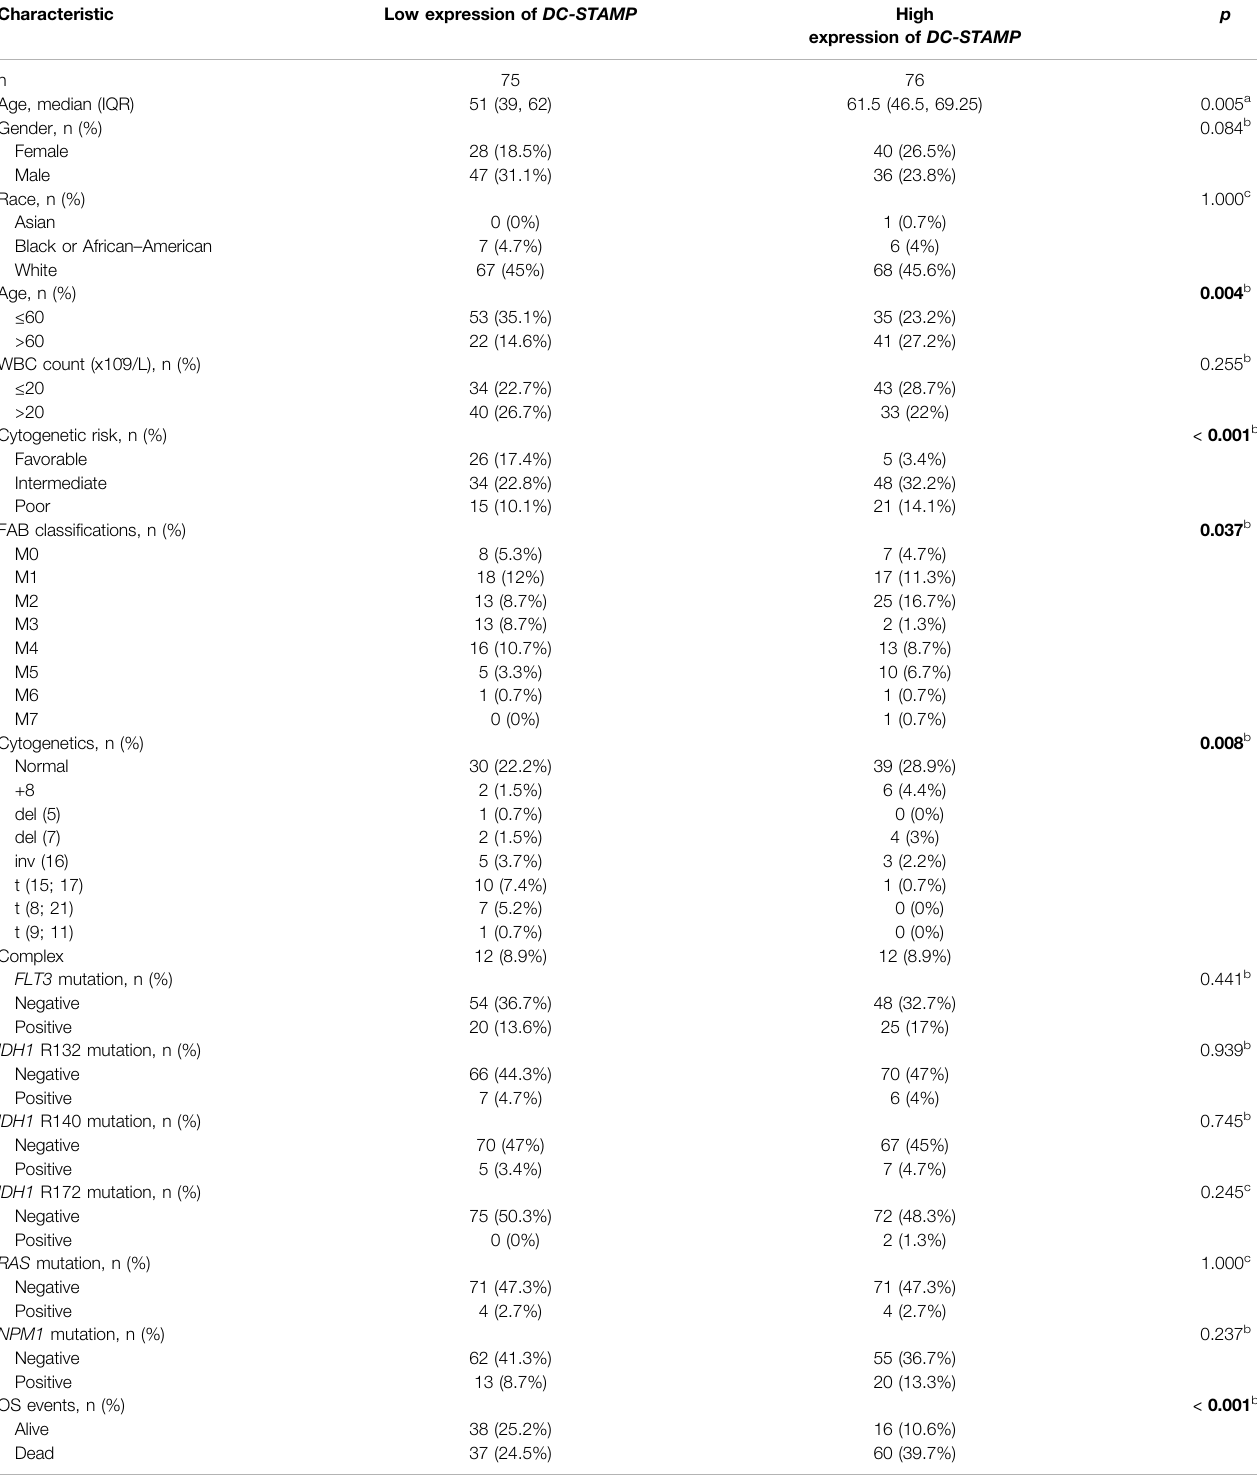
TABLE 1 | Clinical characteristics of AML patients with differential DC-STAMP